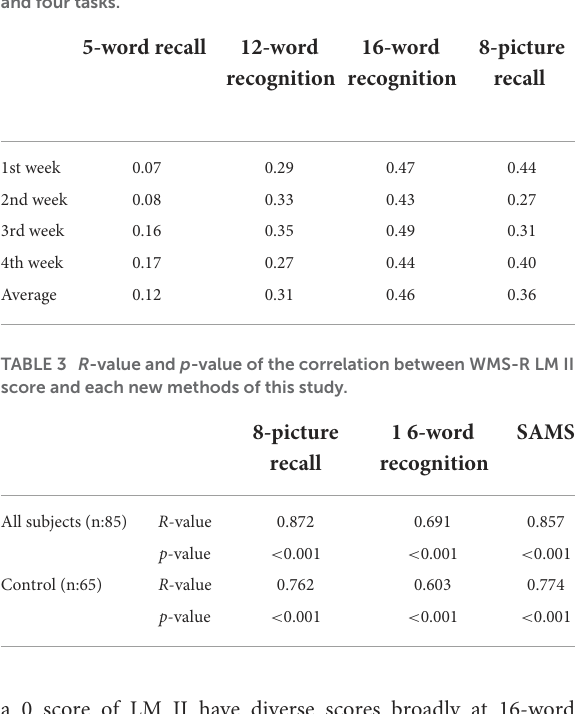
TABLE 2 The R -value of the correlation results of WMS-R LM II score and four tasks.